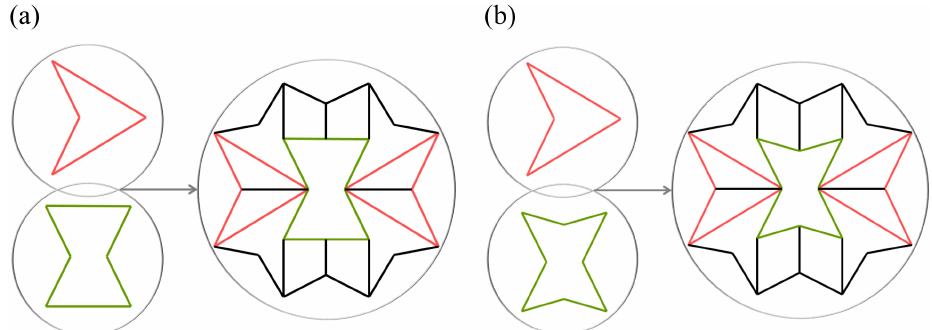
Figure 20. Hybrid structures: ( a ) re-entrant arrowhead (RAH); ( b ) star arrowhead (SAH). The re- entrant, star, and arrowhead structures are illustrated in colors for better understanding. Reprinted with permission from Ref. [136]. Copyright 2023,